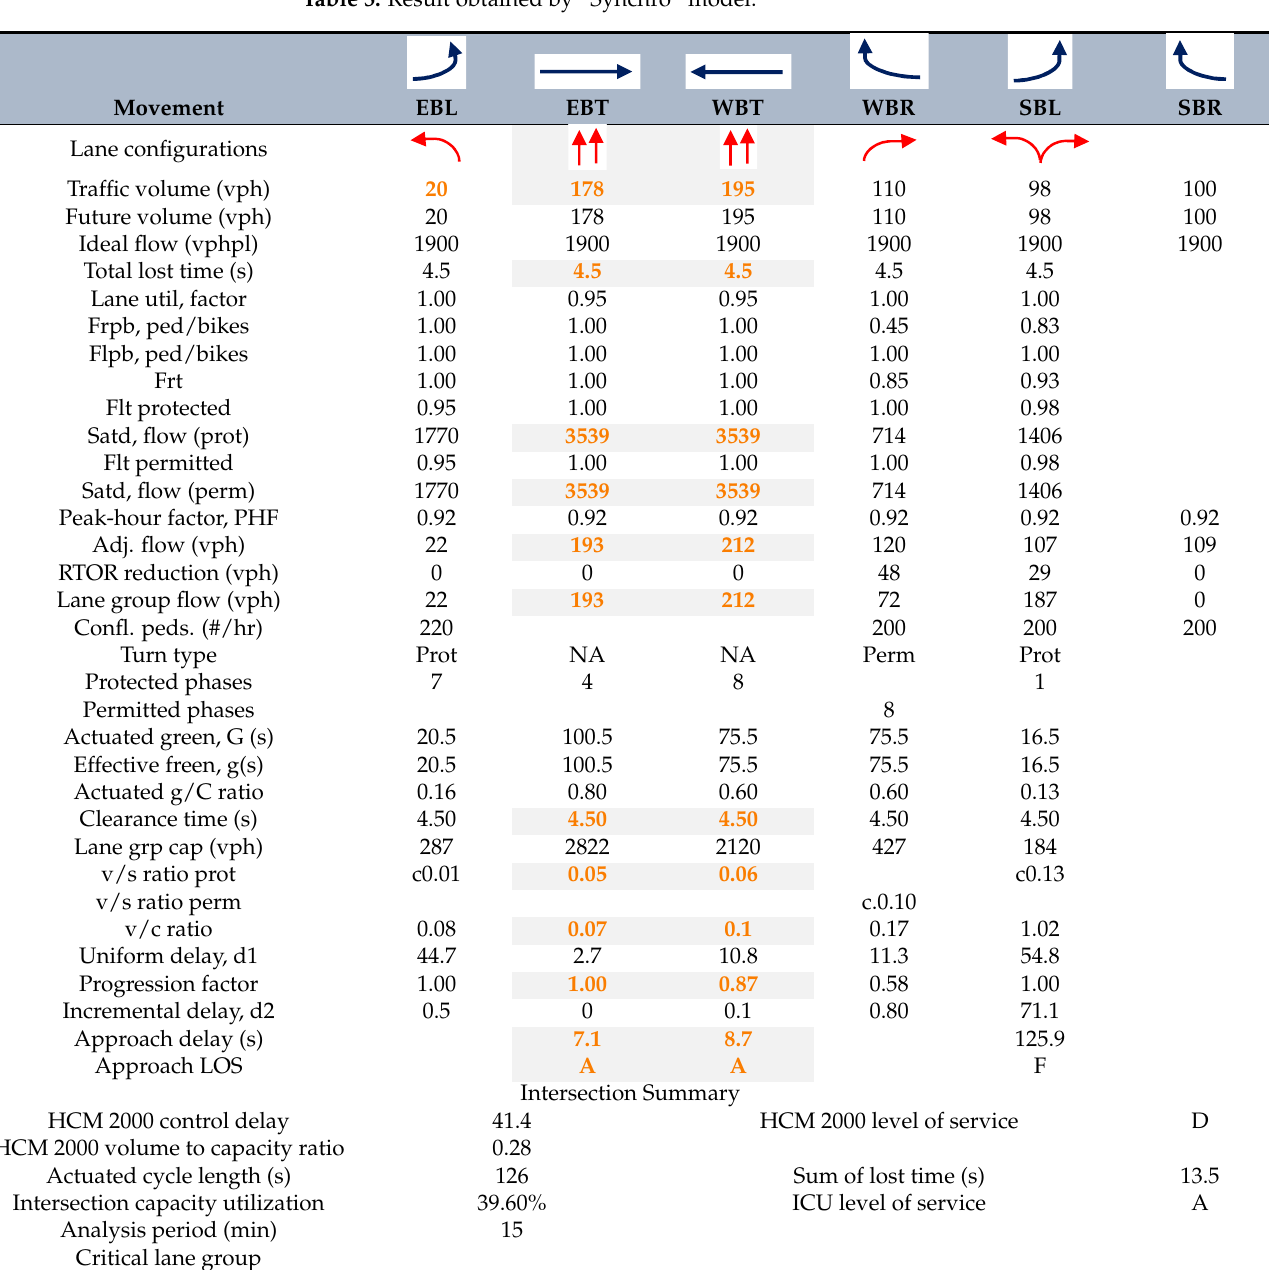
Table 5. Result obtained by “Synchro” model.